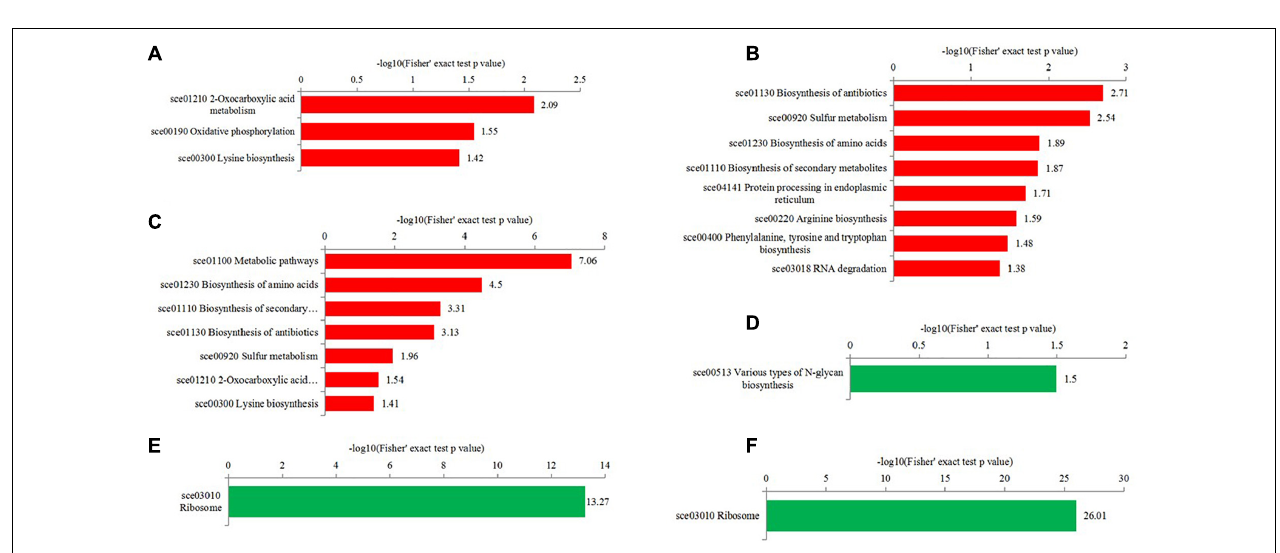
FIGURE 5 | GO-based enrichment analysis of differentially expressed proteins in the different comparisons. (A–C) were upregulated categories in T50/T30, T55/T50, and T55/T30, respectively. (D–F) were downregulated categories in T50/T30, T55/T50, and T55/T30, respectively.